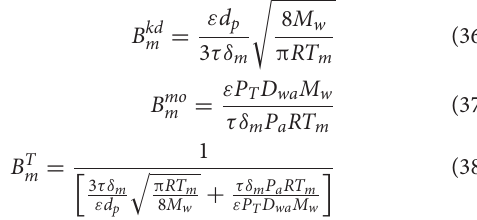
the prevailing mass transfer mechanisms and assumed uniform mean membrane pore